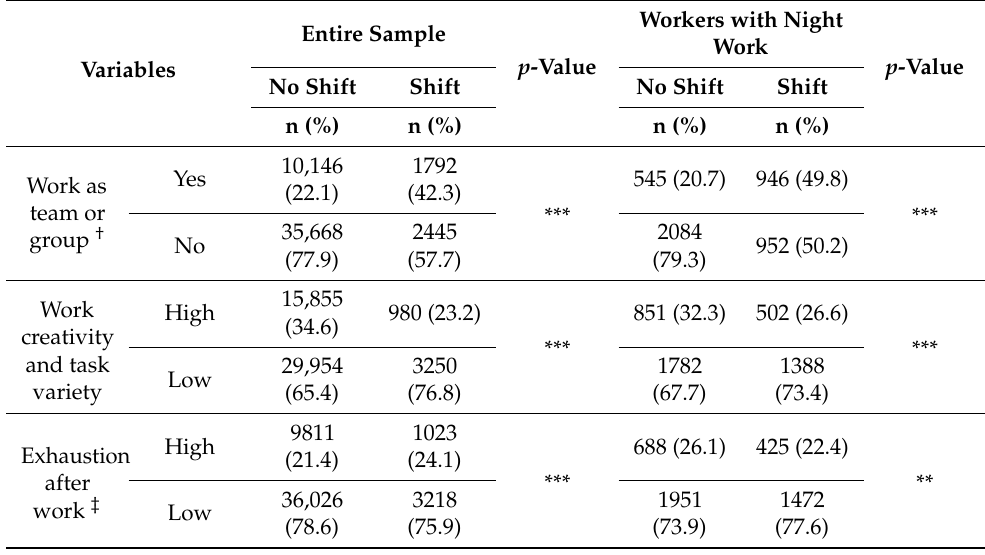
Table A1. Distribution of variables according to shift work among all study subjects and night workers.